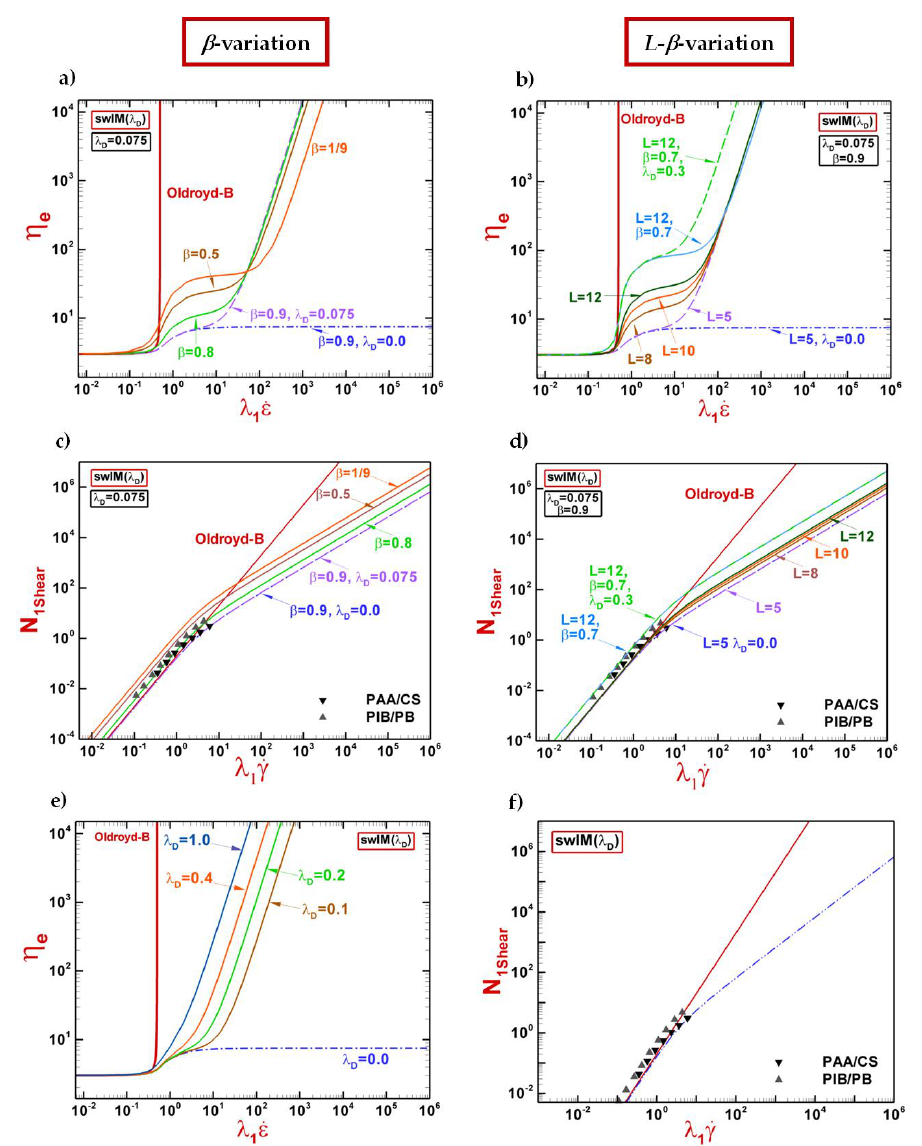
Figure 3. ( a , c ) Extensional viscosity η e ; ( b , d ) first normal-stress di ff erence in shear N 1Shear ; λ = Figure 3. ( a ), ( c ) Extensional viscosity η e ; ( b ), ( d ) first normal-stress difference in shear N 1Shear ; D λ = [0.0, 0.075]; ( a , b ) 1 / 9 ≤ β ≤ 0.9, L = 5; ( c , d ) 5 ≤ L ≤ 10, β = {0.9, 0.7}; ( e ) Extensional viscosity η [0.0,0.075]; ( a ), ( b ) 1/9 ≤ β ≤ 0.9, L = 5; ( c ), ( d ) 5 ≤ L ≤ 10, β = {0.9, 0.7}; ( e ) Extensional viscosity e ; D ( f ) first normal-stress di ff erence in shear N 1Shear ; λ D = [0, 0.1, 0.2, 0.4, 1], β = 0.9, L = 5; Oldroyd-B and λ = [0, 0.1, 0.2, 0.4, 1], β = 0.9, L = 5; η e ; ( f ) first normal-stress difference in shear N 1Shear ; D swIM models; symbols: experimental N 1 Shear data from Boger et al. Oldroyd-B and swIM models; symbols: experimental data from Boger et al. [2].